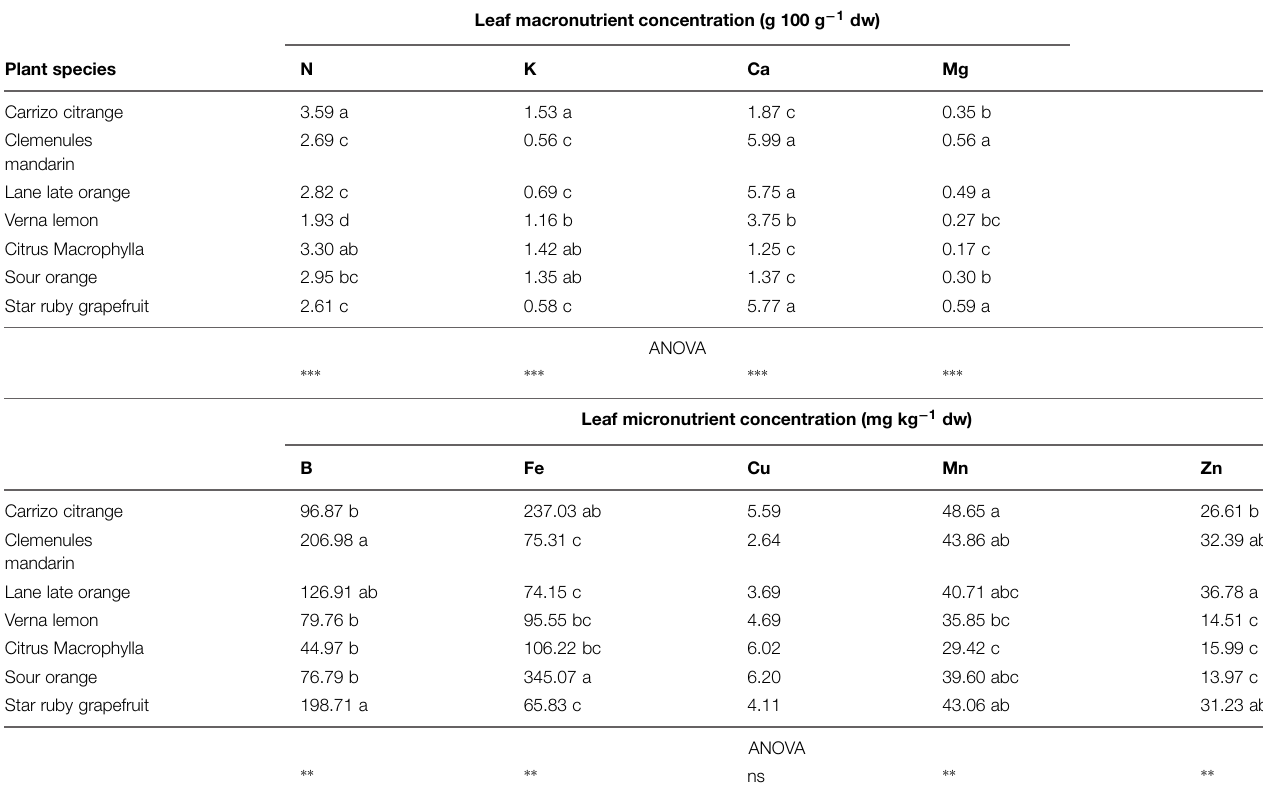
TABLE 2 | Leaf macro and micro-nutrient concentration in the seven citrus plant